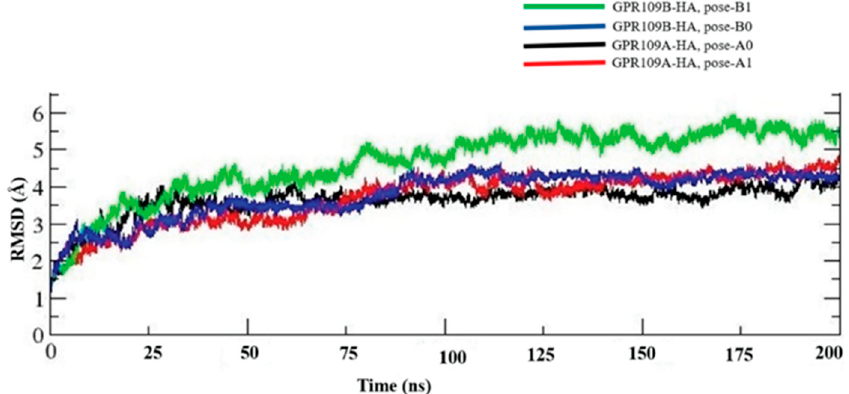
Figure 1. Root Mean Squared Deviations (RMSD) of GPR109A/B-Hippuric Acid (HA) complex.